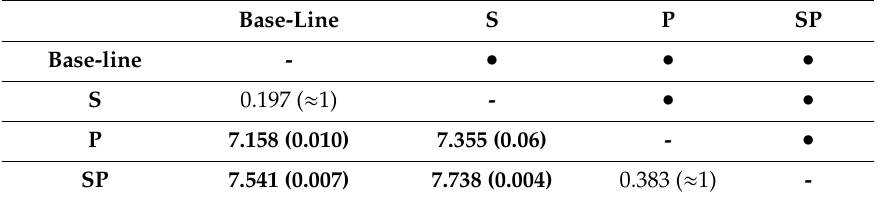
Table 3. One-way ANOVA results in the 50 trials, post-hoc comparisons. The average difference (absolute value) and the associated probability are in parentheses. Statistically detectable differences are in bold.